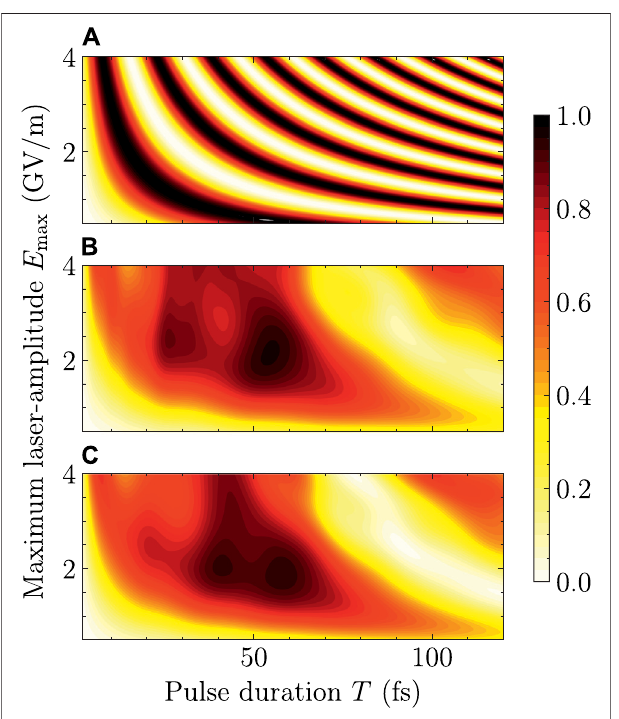
FIGURE 2 | Population of the fi rst electronically excited state of HCCI + versus E max and T illustrated by color-coded contour plots. (A) P FNA e ( t f ) calculated by the FNA. (B) P e ( t f ) obtained by 3D nuclear dynamics simulations. (C) Same as (B) but the nuclear dynamics is one- dimensional.